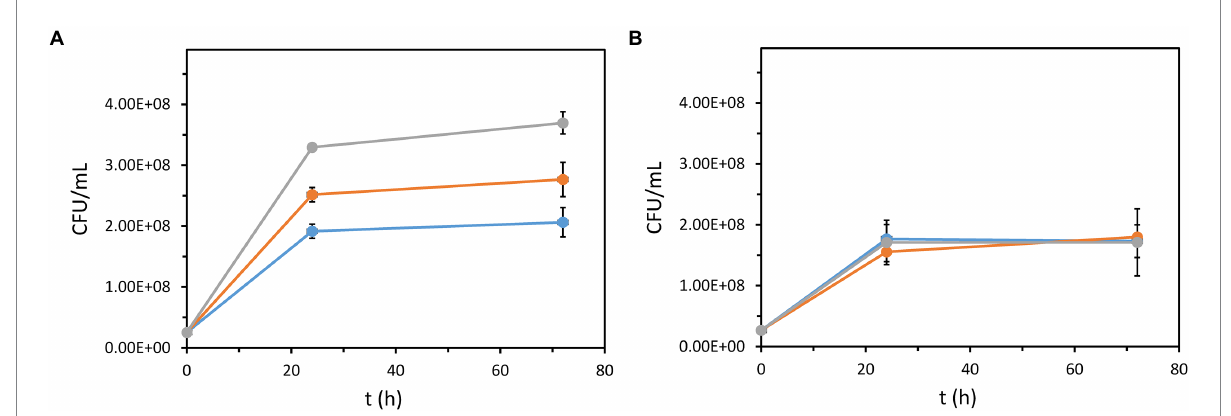
FIGURE 4 Growth of recombinant P. azelaica strains using DBT or 2HBP as a carbon source. P. azelaica AJdsz (A) and P. azelaica AJd hbpA dsz (B) were grown in M63 medium with 6.8 mM glutamic acid (basal carbon and energy source) in the absence (blue lines) or in the presence of 2.5 mM DBT (orange lines) or 2.5 mM 2HBP (gray lines). Due to the high turbidity of the medium, growth was determined as CFU/mL (1 gDCW/L = 5.2·10 8 CFU/ml). Values are the mean of three different experiments. Error bars indicate standard